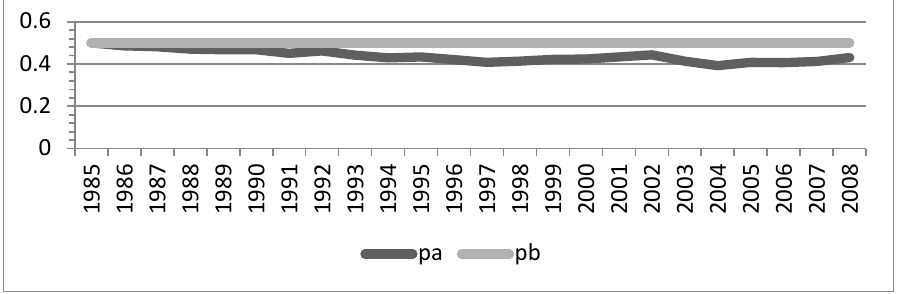
FIGURE 2: Ratio form of the conflict success function from 1985 to 2008, using 1985 as the base year Source: Author’s